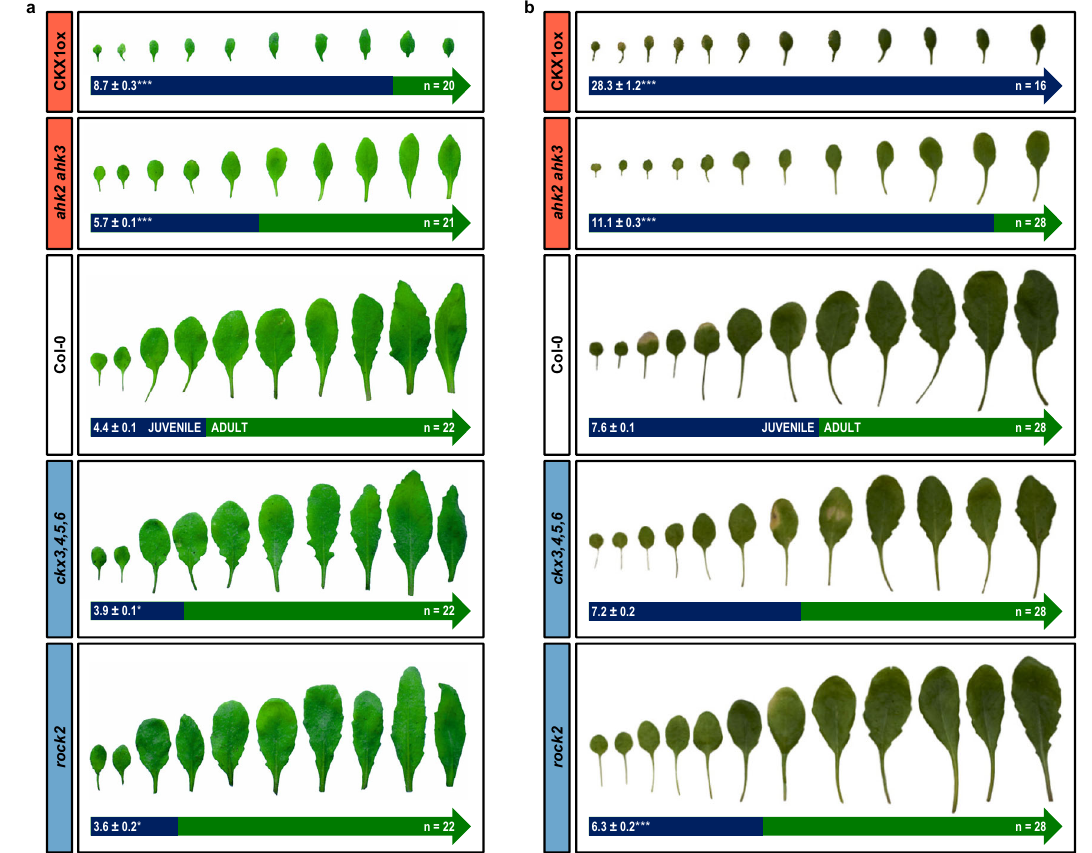
Fig. 1 Cytokinin promotes the juvenile-to-adult phase transition in a photoperiod-independent manner in Arabidopsis . a Morphology of the fi rst ten leaves of Arabidopsis lines with an altered CK status grown in LD. b Morphology of the fi rst 12 leaves of Arabidopsis lines with an altered CK status grown in SD. The color of the arrow indicates juvenile leaves (blue) and adult leaves (green). Values indicate the mean number of leaves without abaxial trichomes ± SEM. Asterisks indicate signi fi cant differences compared to the wild type of the respective experiment, as calculated by Kruskal – Wallis test (* q < 0.05; ** q < 0.01; *** q < 0.001). Exact q -values are included in the Source Data fi